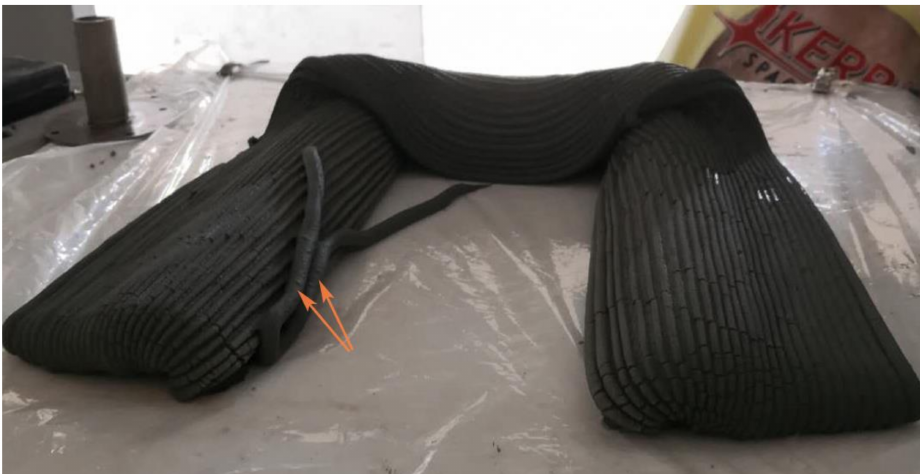
Figure 7. A collapse occurred during a U-shaped component printing process, and the extruded filaments fell onto the platform, as the arrows show.